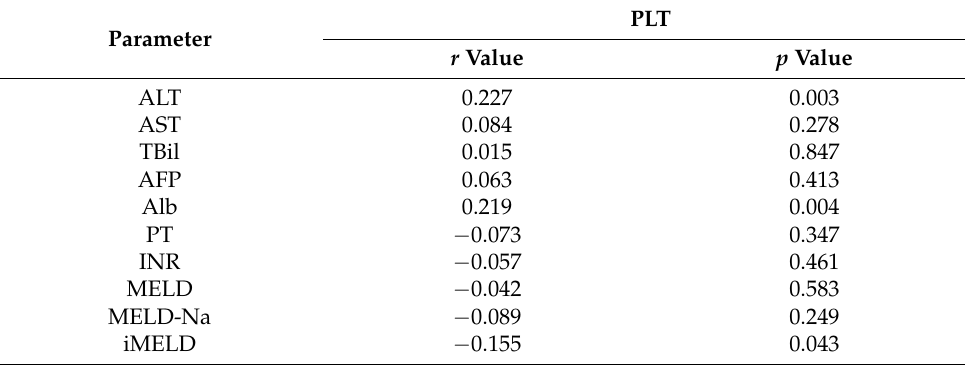
Table 2. Correlation of PLT with liver function parameters and MELD series scores.